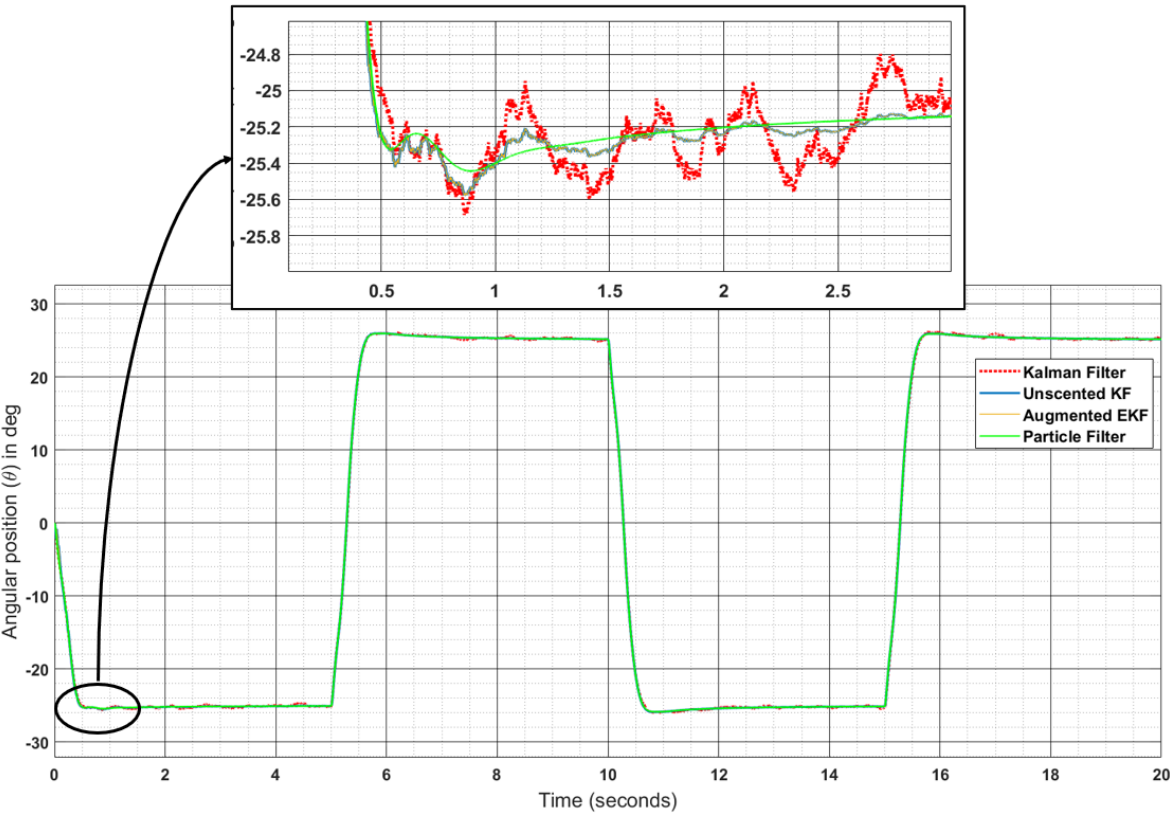
Figure 12. Integer and fractional order controller comparison for different state estimation methods for Joint 1.